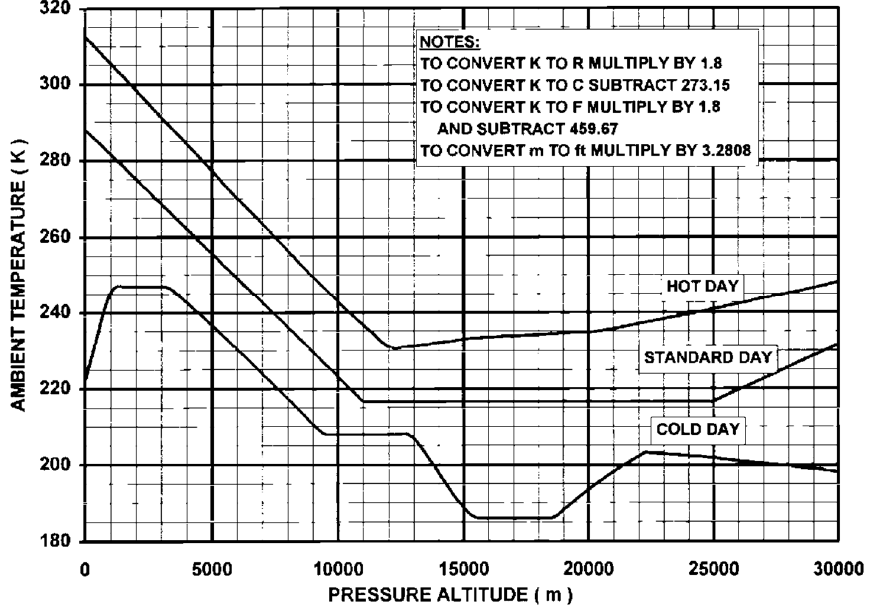
Figure 5. ISA hot and cold day ambient temperature variations with altitude [45].